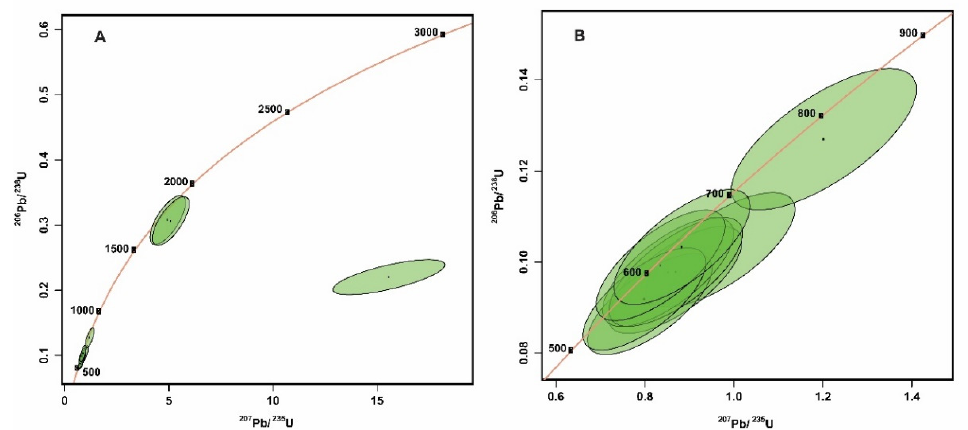
Figure 3. Concordia diagram [86]. ( A ) for all dated zircon U-Pb ages representing the two pre-Pan-African grains, ( B ) for all grains with Pan-African ages which gives weighted mean age of 599 ± 30 Ma (7 grains) if the older D3 grain was excluded.